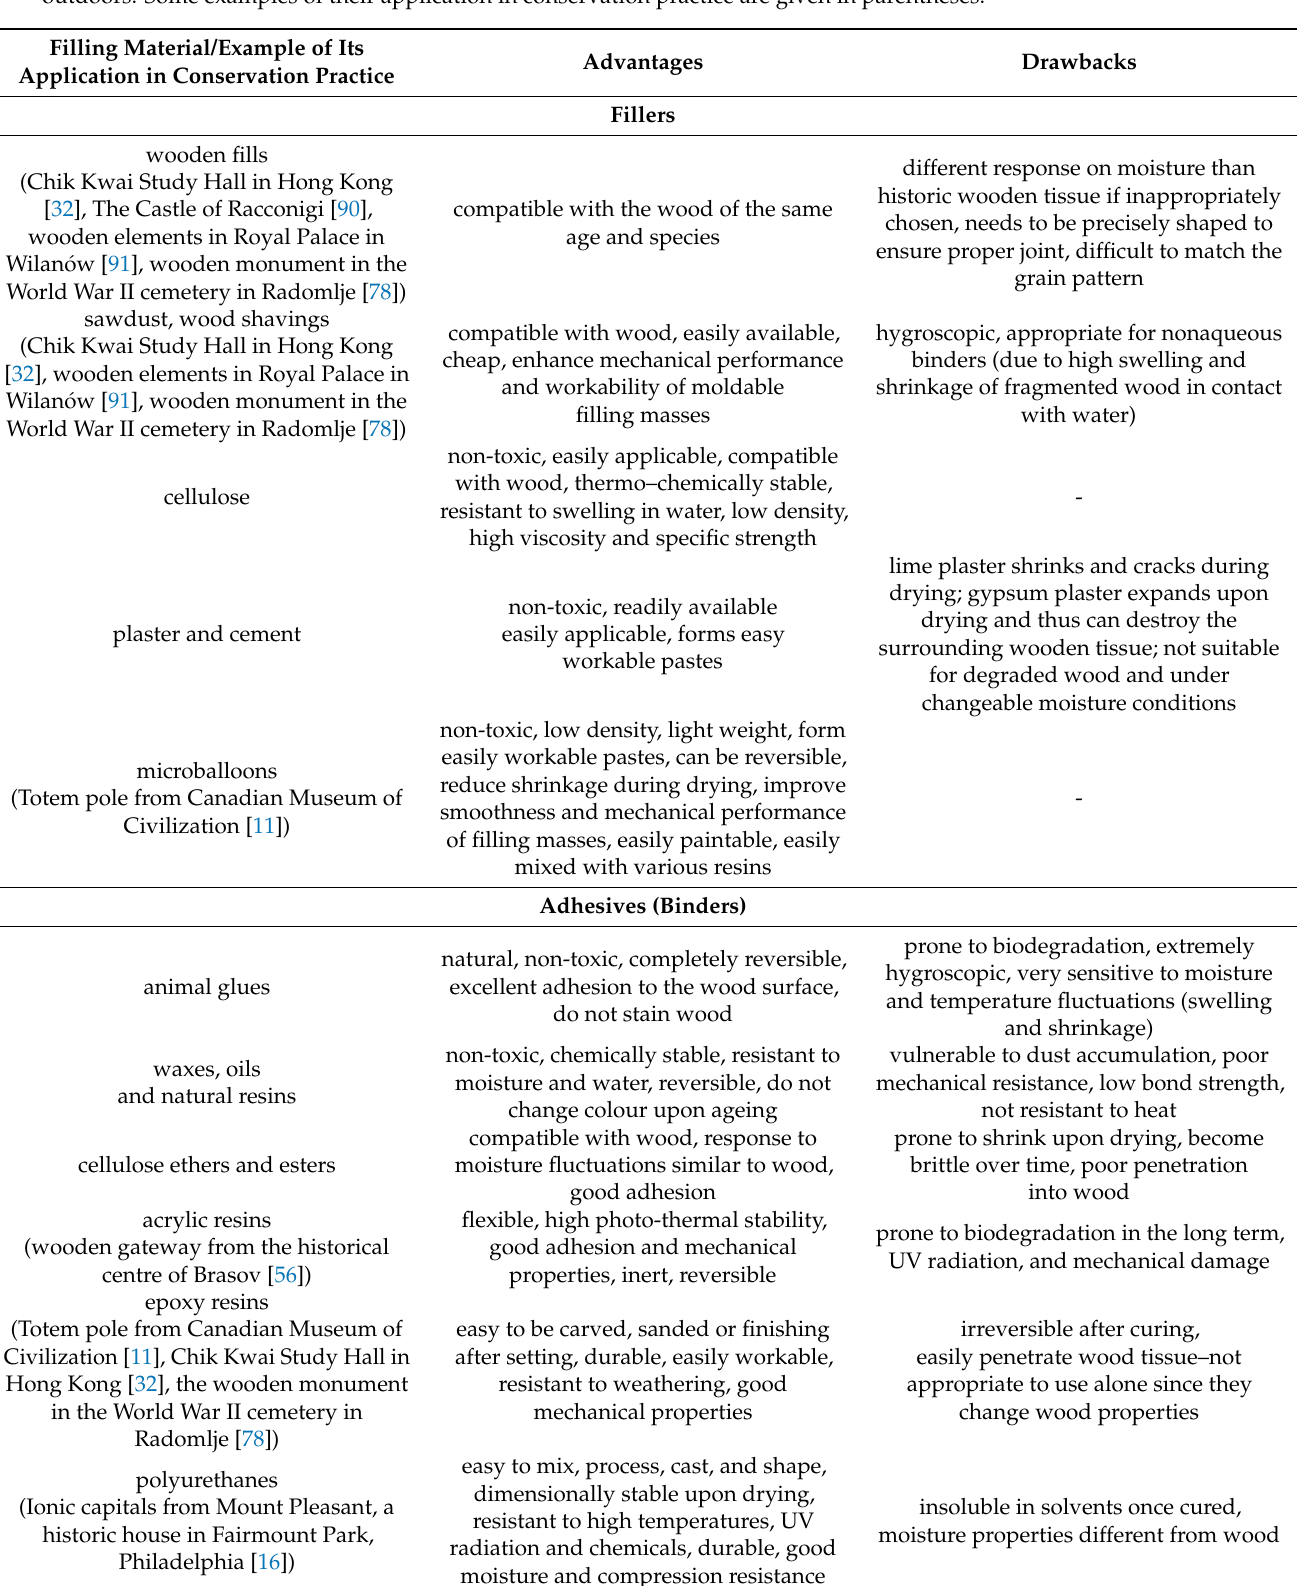
Table 1. A summary of advantages and disadvantages of different materials for filling gaps in wooden artefacts exposed outdoors. Some examples of their application in conservation practice are given in